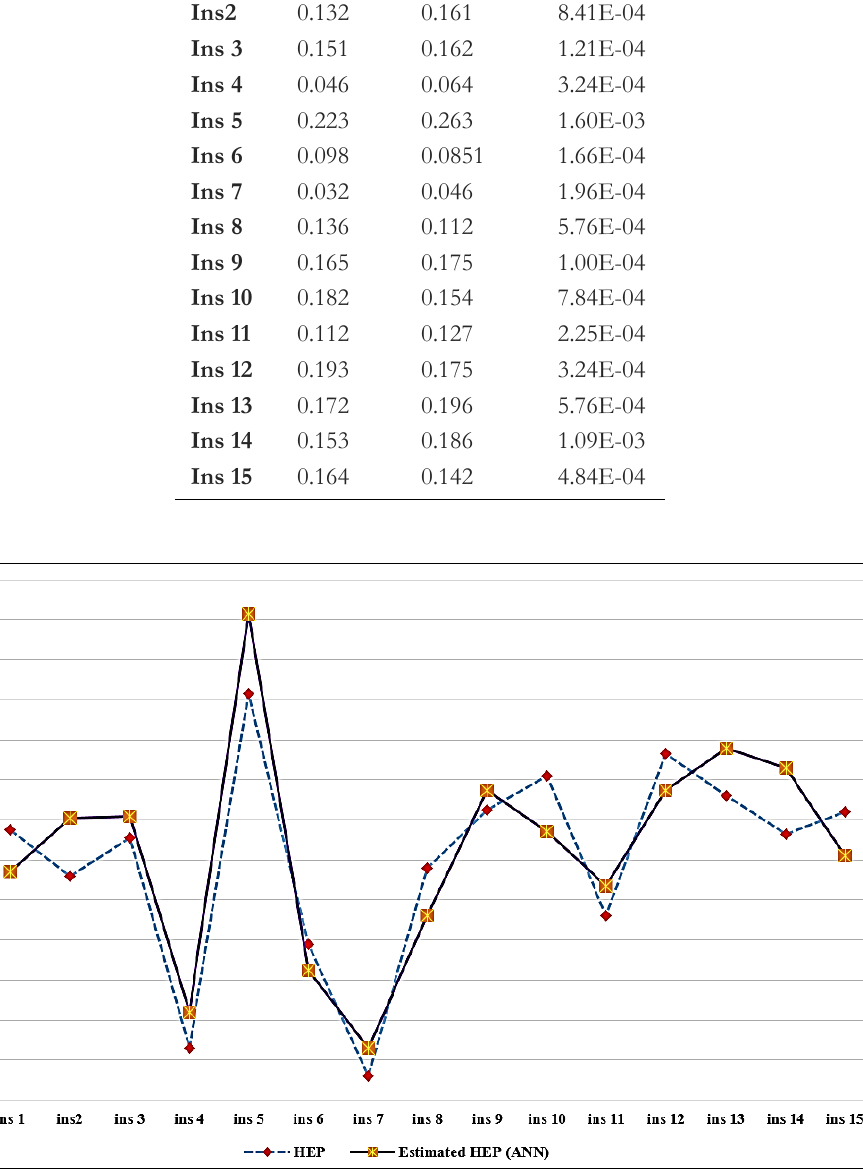
Fig. 4. The original HEP vs. HEP proposed By